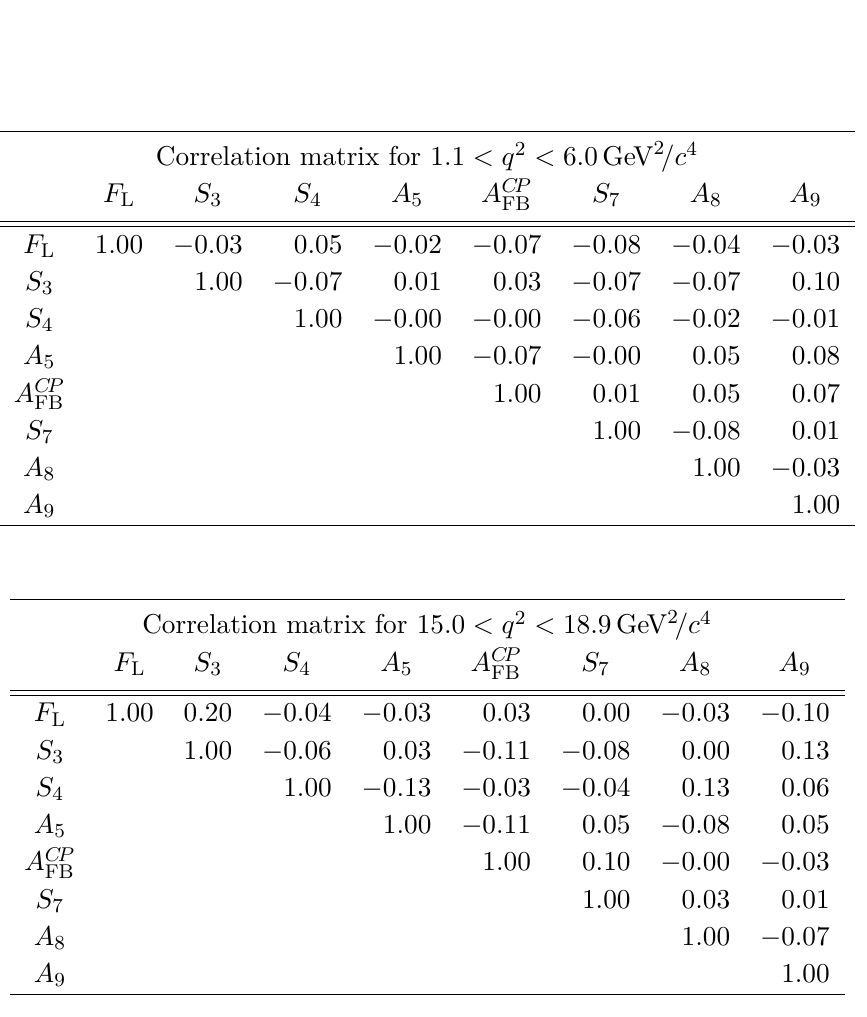
Table 5 . Correlation matrix for the q 2 region 1 . 1 < q 2 < 6 . 0 GeV 2 /c 4 and 15 . 0 < q 2 < 18 . 9 GeV 2 /c 4